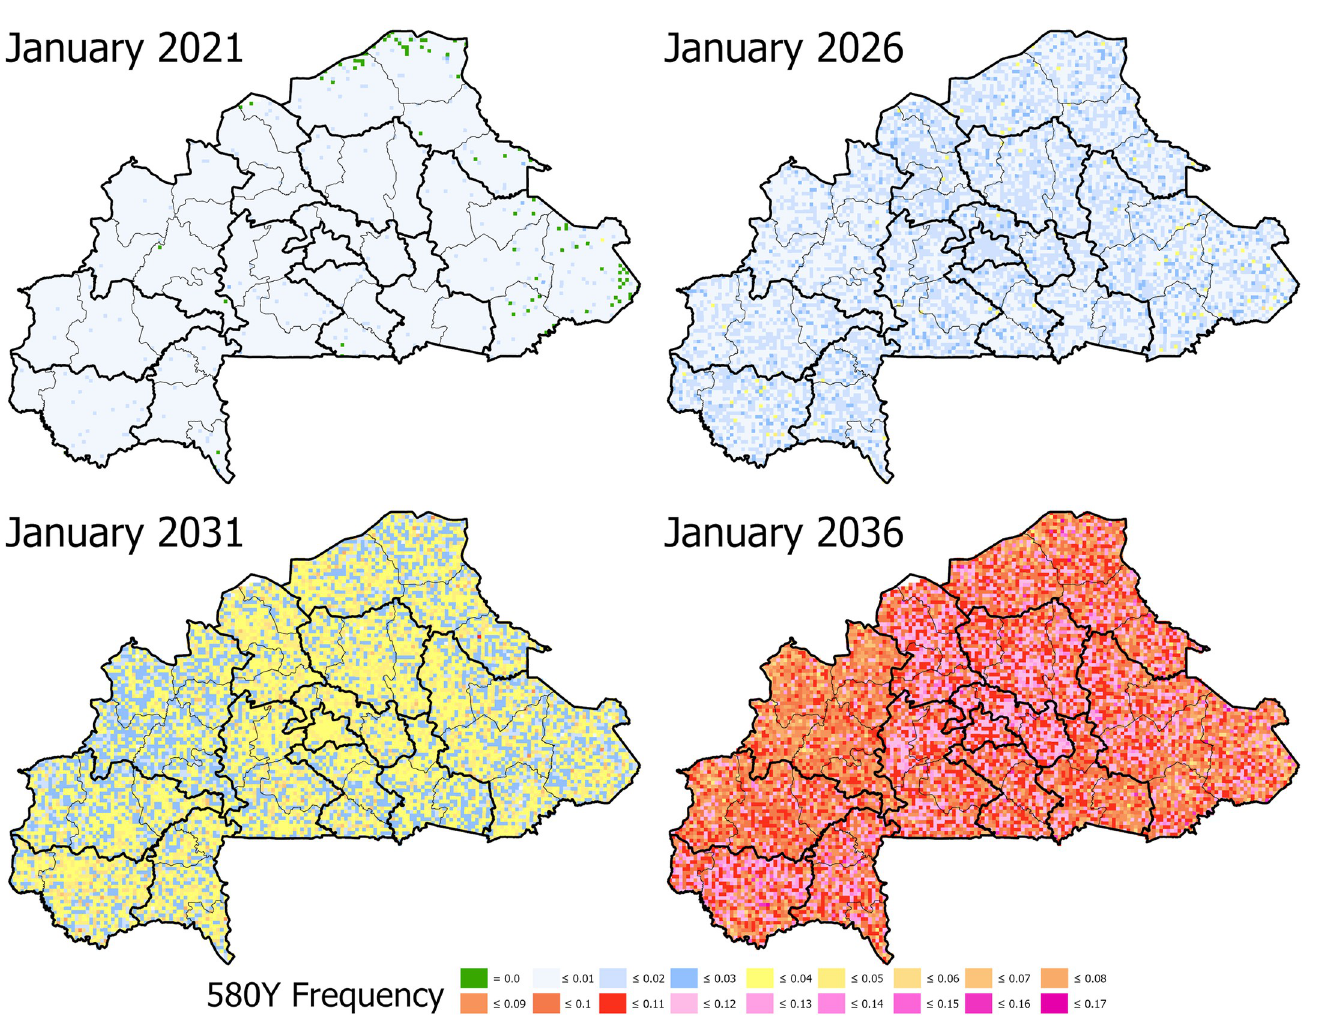
Fig 3. De novo emergence of artemisinin resistance under the baseline, status quo scenario. In the baseline scenario, C580 is allowed to mutate to 580Y using a mutation rate that has been set to a previously calibrated pattern of artemisinin resistance in the presence of widespread ACT usage. The appearance of artemisinin resistance in model year 2021 appears to be stochastic with only minimal evidence of elevated frequency of the mutation and some cells with no occurrences. However, by model year 2036 the highest frequencies of artemisinin resistance correspond to areas with elevated to high transmission and high access to treatment. Burkina Faso administrative boundaries from the World Bank Group